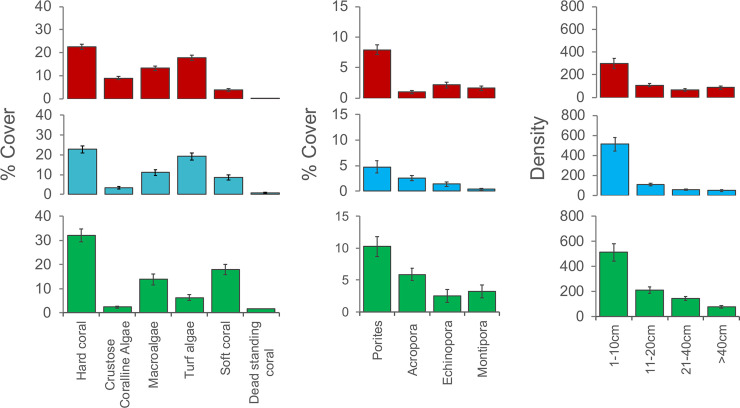
Summary of benthic community variables by geographic zone.Mean percentage cover of five major benthic cover categories, four coral genera and density (number of colonies per 100m2) of four coral size classes for north (upper, red), central (middle, blue) and south (lower, green) geographic zones. Error bars indicate standard error.